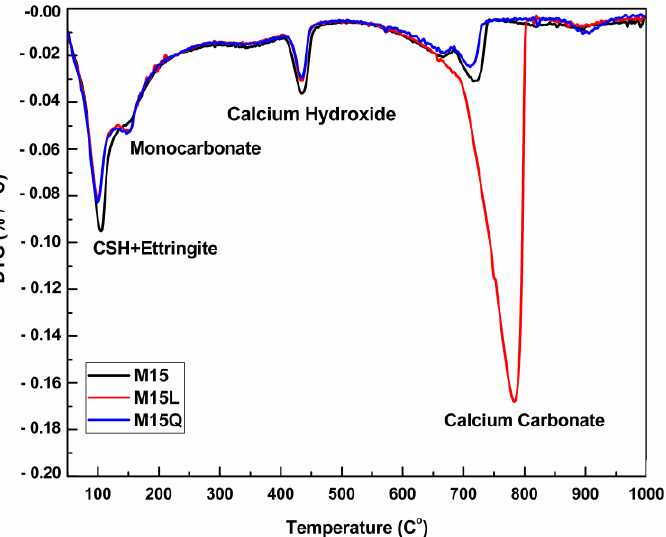
Figure 4. Derivative of the Thermogram for the paste fractions of mixtures M15, M15L and M15Q at 91 days.